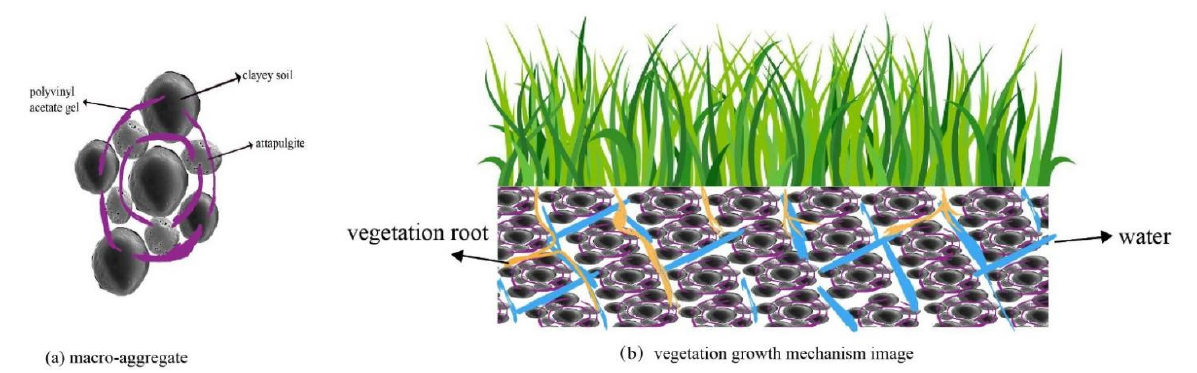
Figure 14. ( a ) Modified clayey soil with PVA and attapulgite; ( b ) vegetation growth mechanism image of modified clayey soil.